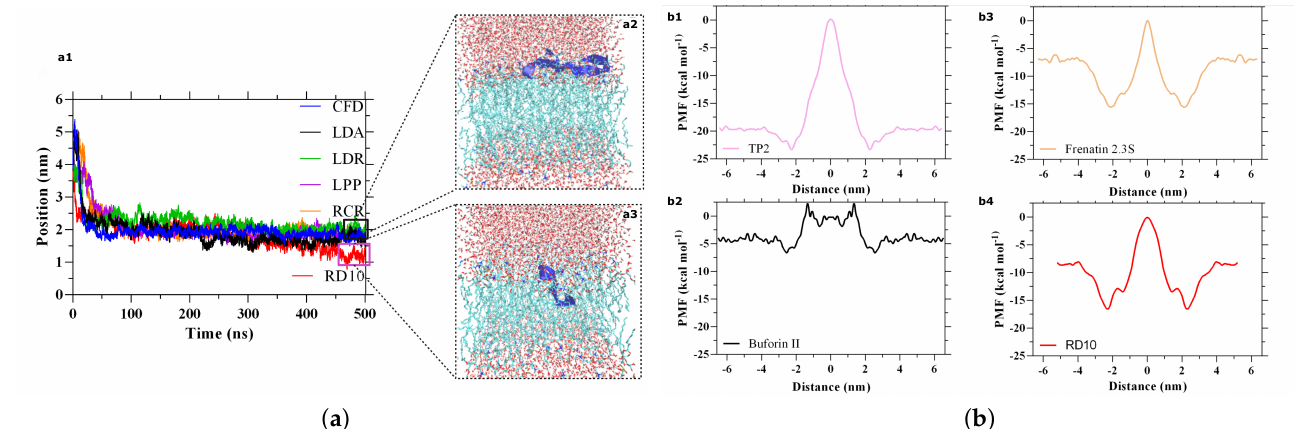
Figure 6. RD10 peptide interaction with a model lipid bilayer as estimated by Molecular Dynamic (MD) simulations. ( a ) Penetrating capability of multiple promising candidates. Only the RD10 peptide can penetrate the cellular membrane. ( b ) PMF profiles of RD10 and three already validated cell-translocating peptides in vitro. ( a ) Flat bottom. ( a1 ) Peptides position traces within the simulation box for 500 ns. Cellular membrane positioned at 2.4 nm. Only the RD10 sequence is likely to penetrate the cellular membrane; however, the other candidates seem to interact with the headgroups of the phospholipid bilayer strongly and remain therein. ( a2 ) Final position of the CFD peptide. ( a3 ) In its final position, the RD10 peptide has completely penetrated the bilayer and is located deeper within the hydrophobic core. ( b ) Umbrella Sampling. Free energy profile (PMF) for peptides translocating a simplified eukaryotic membrane. ( b1 ) TP2, a cell-penetrating peptide added for comparison. ( b2 , b3 ) The antimicrobial peptide Frenatin 2.3 and the antimicrobial, cell-penetrating, and DNA binding peptide Buforin II. Also added for comparison. ( b4 ) RD10, an antimicrobial and cell-penetrating